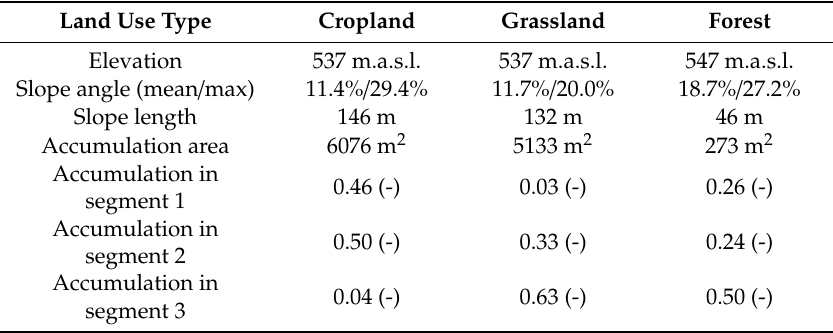
Table 1. Description of the three measurement